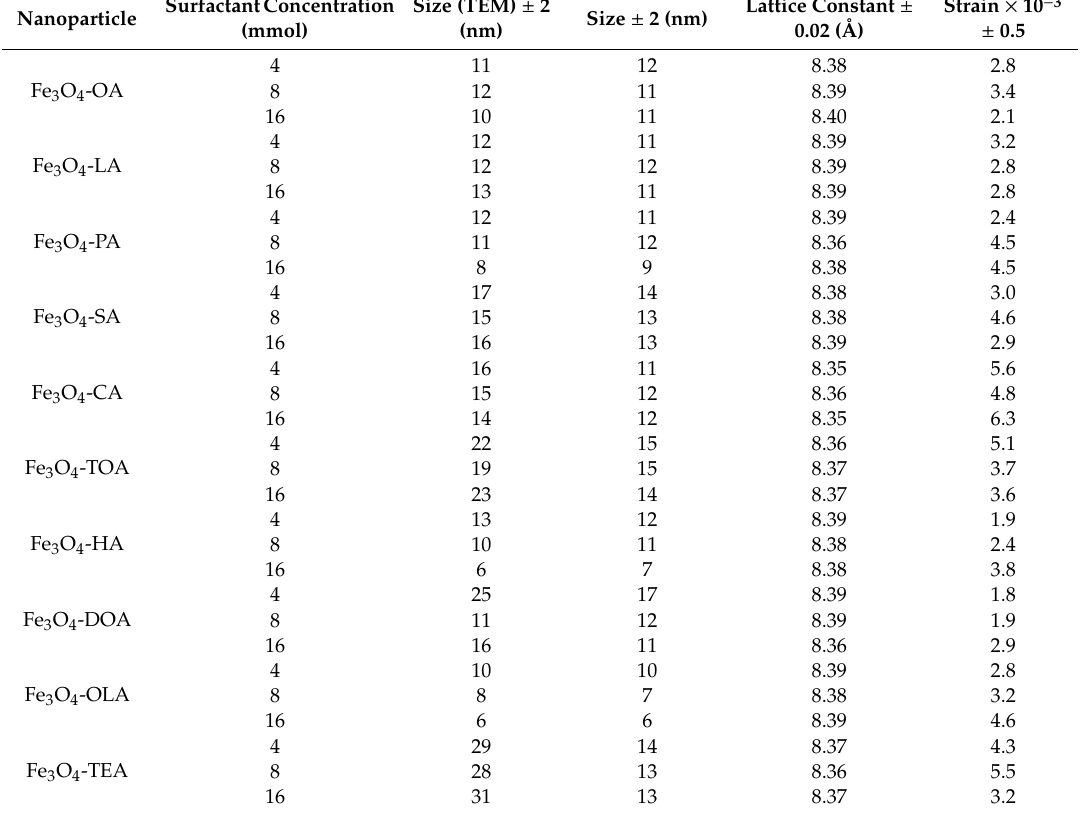
Table 2. Summary of estimated grain sizes from TEM images and X-ray di ff raction. Lattice constants and lattice strain values were determined from